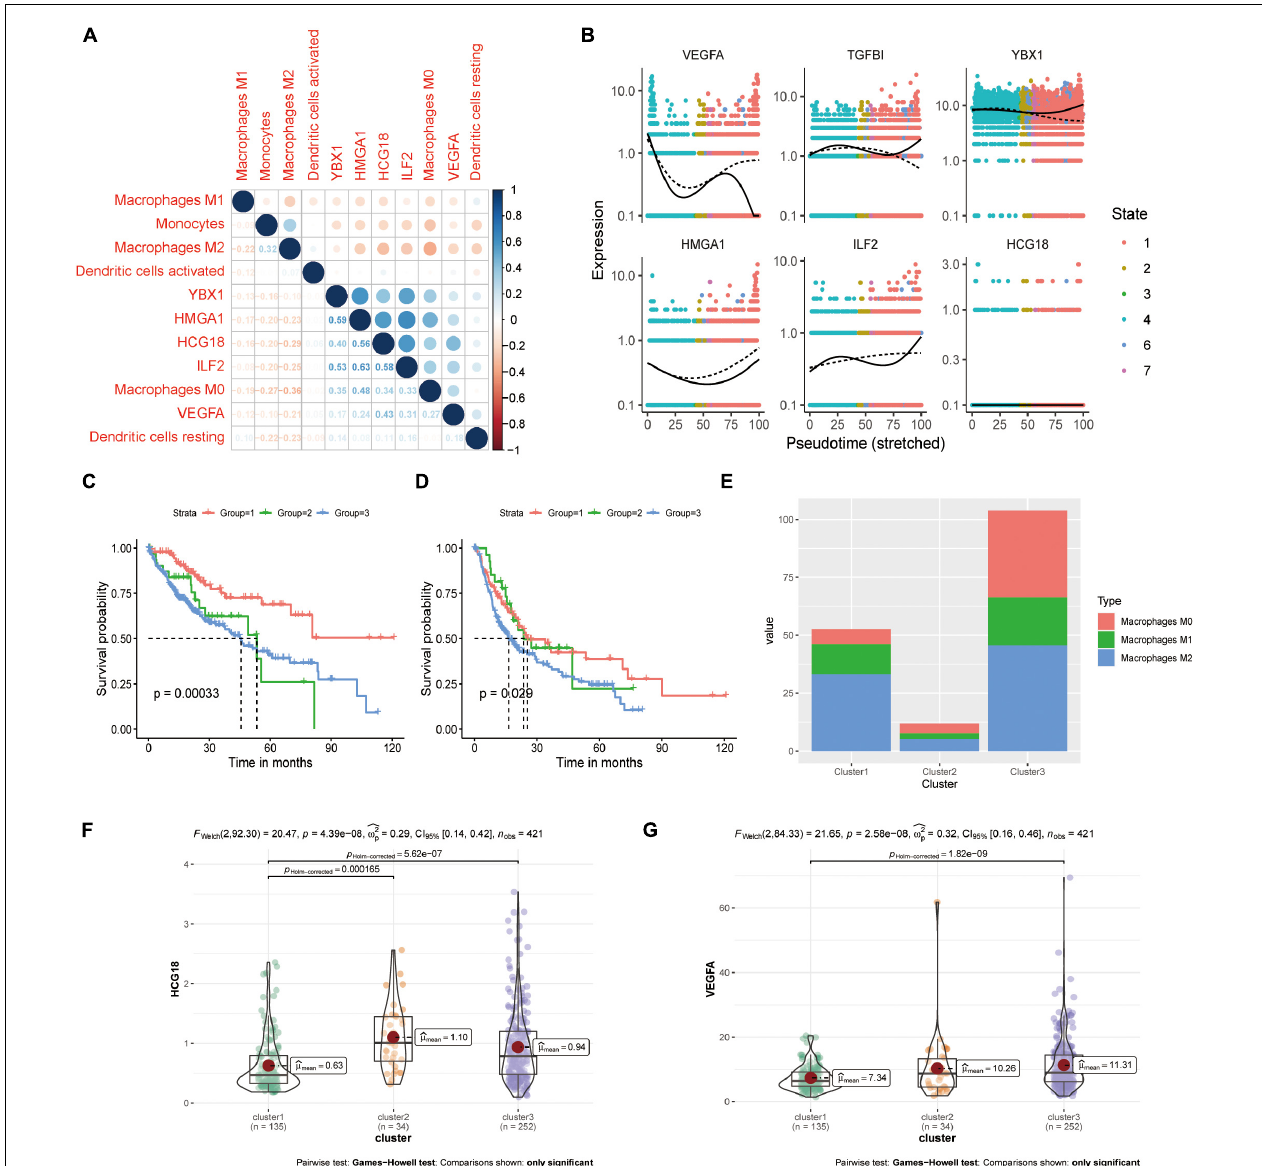
FIGURE 5 | HCG18 is associated with M0 macrophages in the mononuclear macrophage system. (A) Correlation analysis of the expression of HCG18, HMGA1, ILF2, YBX1, and VEGFA upon infiltration of monocyte macrophages and DCs in tumors. (B) Pseudo-time locus analysis of HCG18, HMGA1, ILF2, and YBX1 regulating phenotypic differentiation of monocytes and macrophages. (C) Cluster analysis based on immune infiltrating cells divided the patients into three subtypes. Overall survival curves of the three subtypes are shown. (D) Survival curves of the three subtypes in disease-free progression. (E) Cumulative histogram of infiltrating macrophages in the three subtypes. (F) HCG18 expression level in the three subtypes. (G) Expression of VEGFA in the three